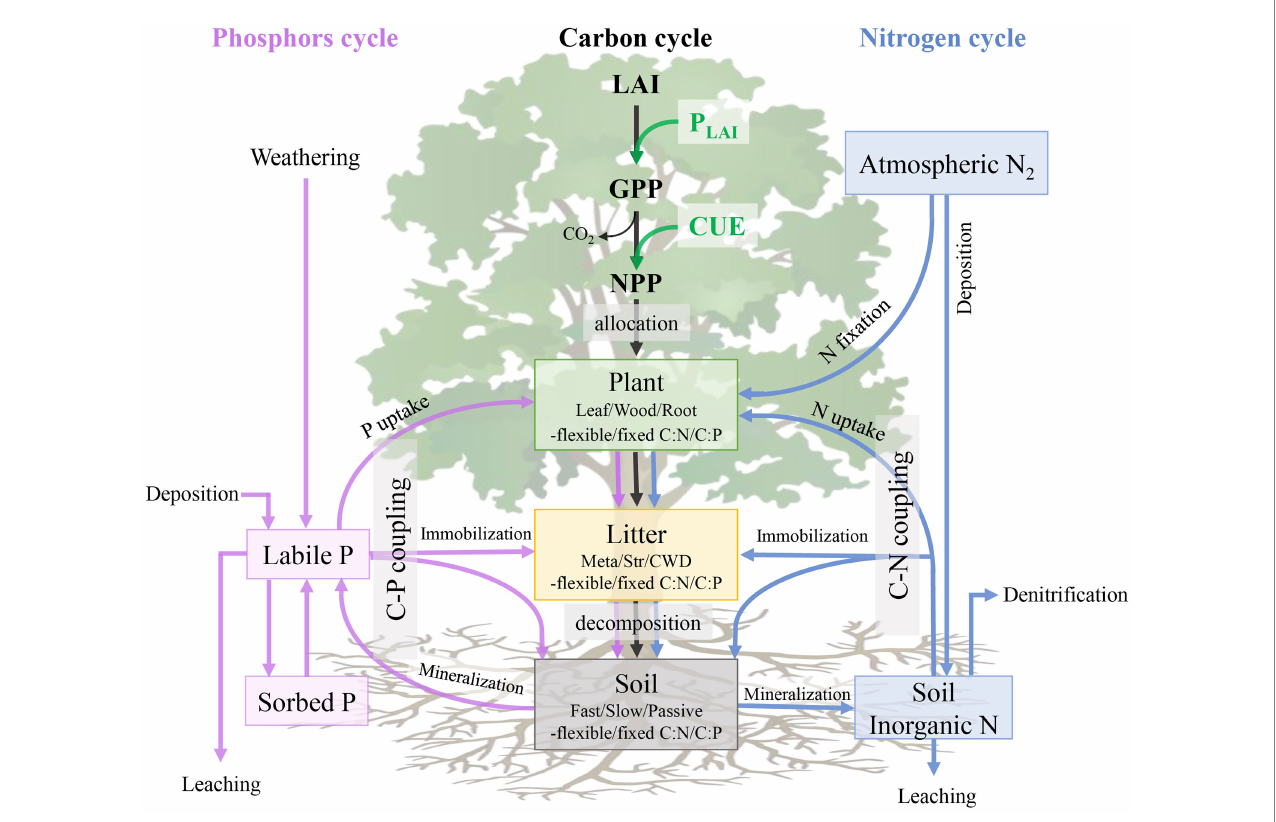
FIGURE 1 Schematic diagram of major carbon (C), nitrogen (N) and phosphorus (P) pools and fluxes in a terrestrial ecosystem. Black, blue and pink arrows indicate the C-cycle processes, N-cycle processes, and P-cycle processes, respectively. Green, yellow, and gray rectangles represent the vegetation, litter and soil pools of organic carbon, nitrogen, and phosphorus. LAI, leaf area index; P LAI , LAI-leval photosynthesis, GPP, gross primary productivity, CUE, carbon use efficiency; NPP, net primady productivity; Meta, metabolic litter; Str, structural litter; CWD, coarse woody